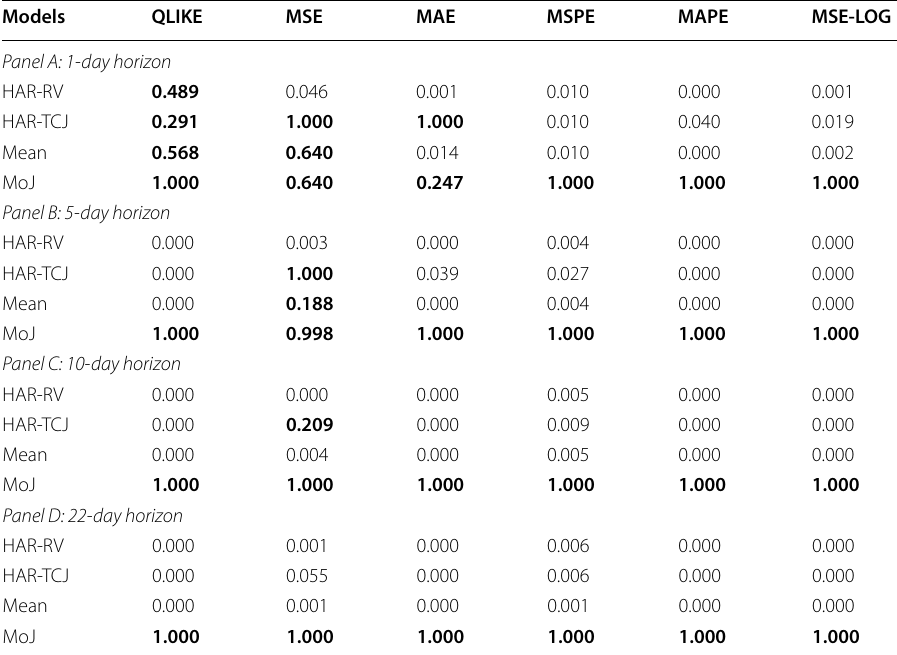
Table 5 MCS out-of-sample forecasting test using the HAR-TCJ jump model